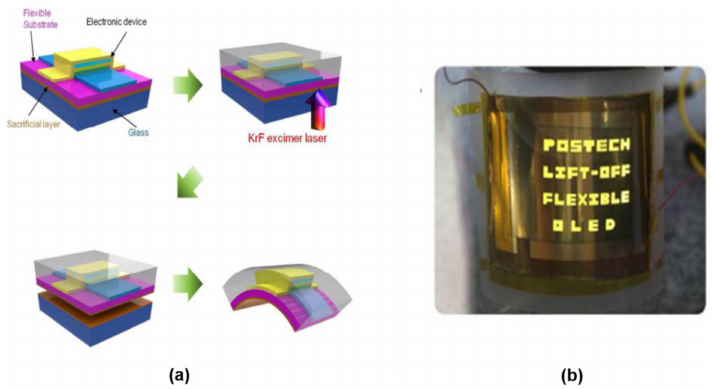
Figure 7. ( a ) Schematic diagram of the process flow for fabricating flexible OLED display by LLO. ( b ) The corresponding flexible OLED display fabricated by laser lift-off (LLO) based on the technology shown in ( a ). A 248 nm excimer KrF laser with a pulse width of 25 ns is used for the LLO. Adapted with permissions from [188]. Copyright Royal Society of Chemistry, 2014.